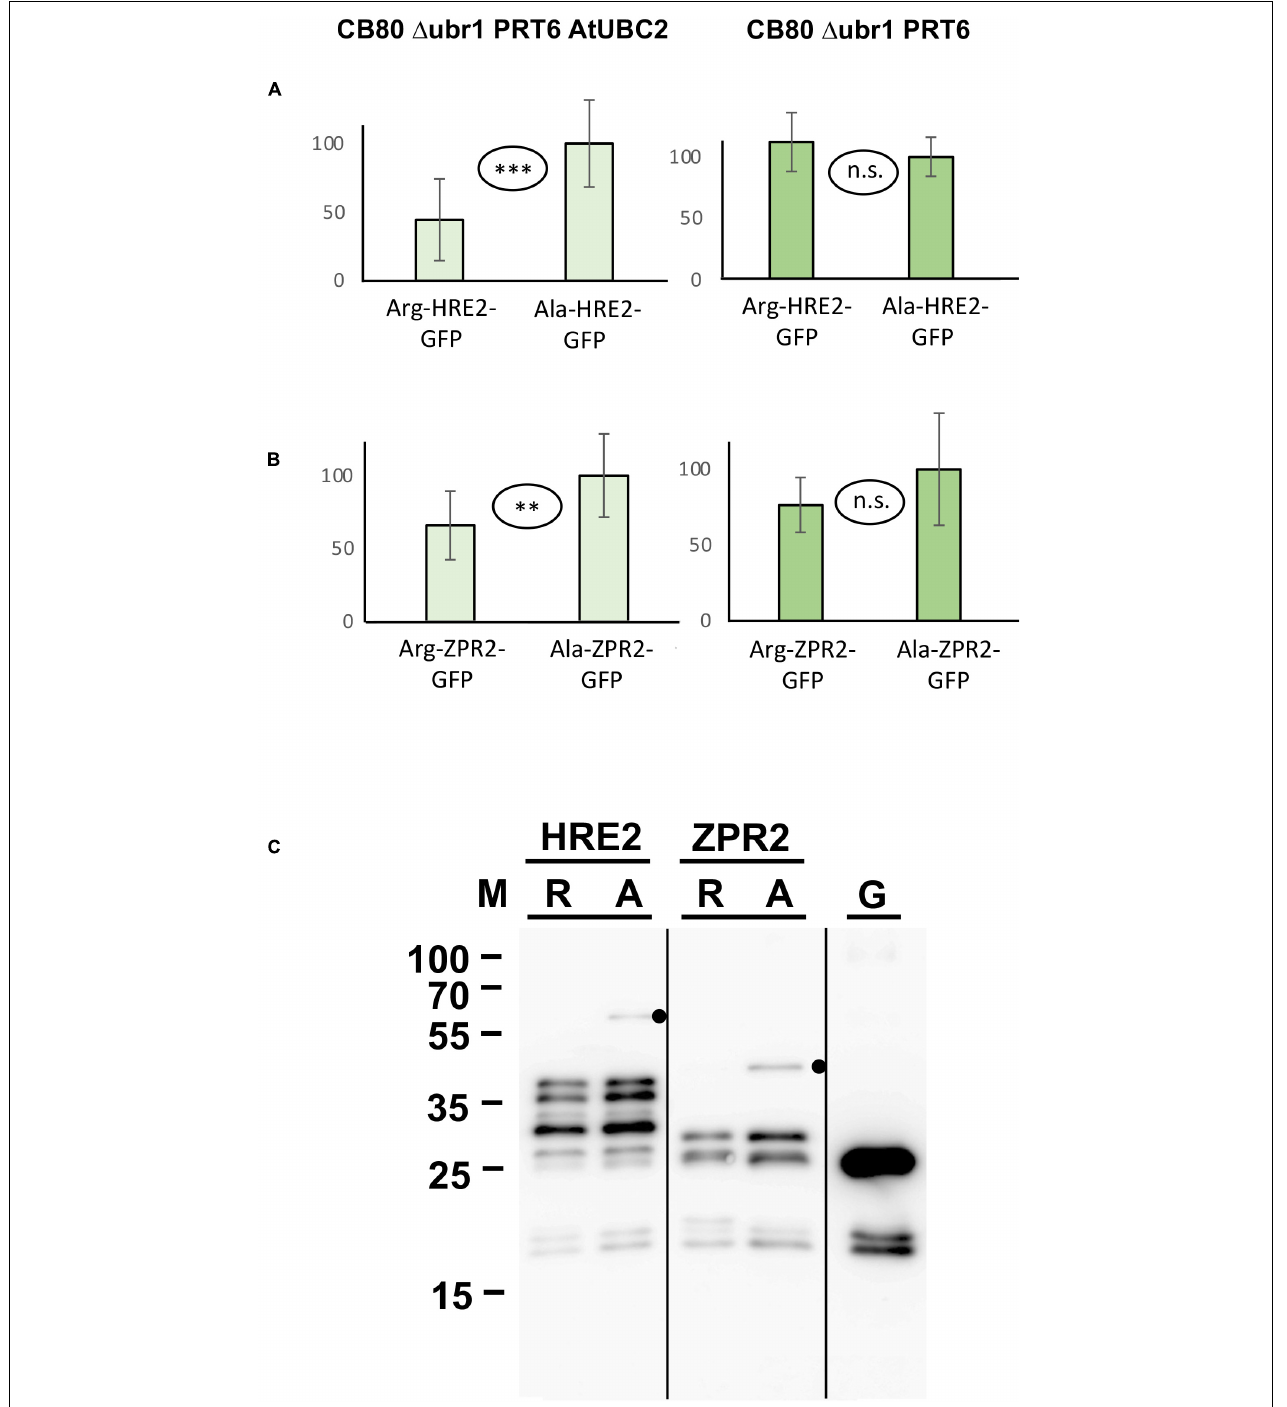
FIGURE 4 | Steady-state levels of Arabidopsis substrates of PRT6 in different yeast strains. The GFP fusions with HRE2 and ZPR2, respectively, start either with Arg or with Ala (see Figure 3 and text for amino-terminal processing, and Supplementary File 3 for amino acid sequences). (A,B) Mean abundance of the proteins starting with Ala was set 100%. Standard deviations are shown as error bars. Measurements were carried out 2 h after inoculation of microtiter wells. Plates were kept at 30 ◦ C to allow yeast growth. Differences are indicated as highly significant ( ∗∗∗ p < 0.001, two-sided t test), significant ( ∗∗ p < 0.01, two-sided t test) and not significant (n.s. p > 0.05, two-sided t test). Twelve replicates were used for each column. Numerical data are listed in Supplementary File 6 . (C) Western blot detection of GFP fusion proteins starting with Arg (R) or with Ala (A). Extracts were taken from yeast strain expressing PRT6 and AtUBC2. Note increased level of the full-length proteins starting with Ala. Unfused GFP (G) is shown in the right lane. Dots indicate expected positions of full length fusion proteins.